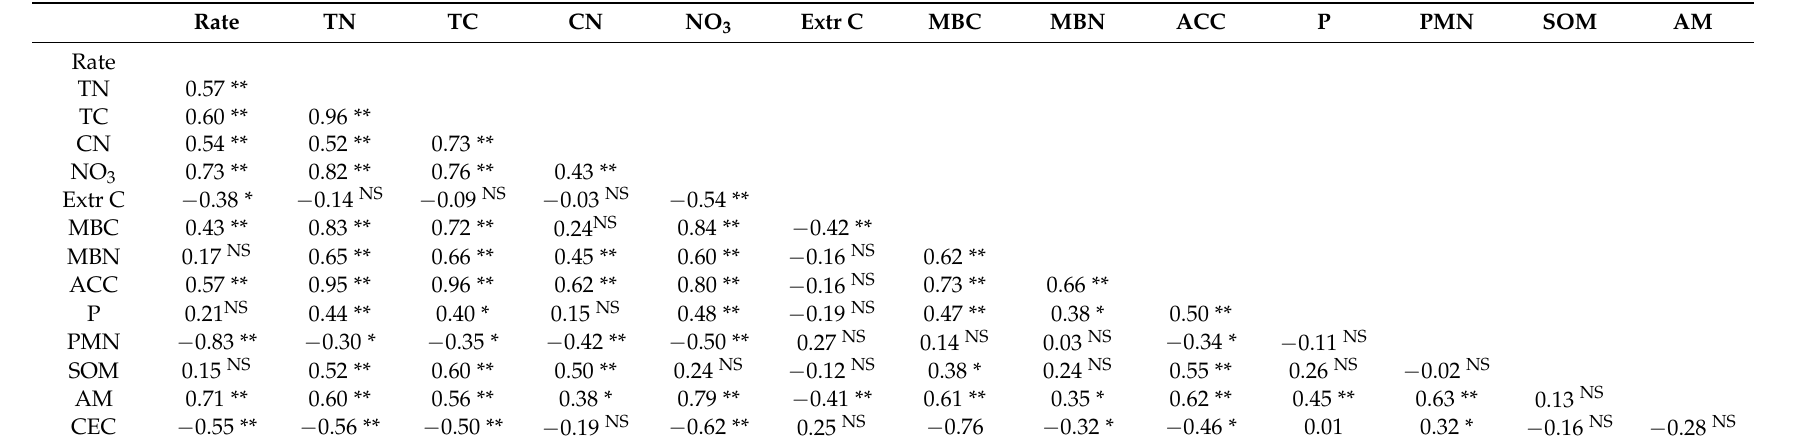
Table 2. Linear correlation among the analyzed biological and chemical soil parameters ( n =